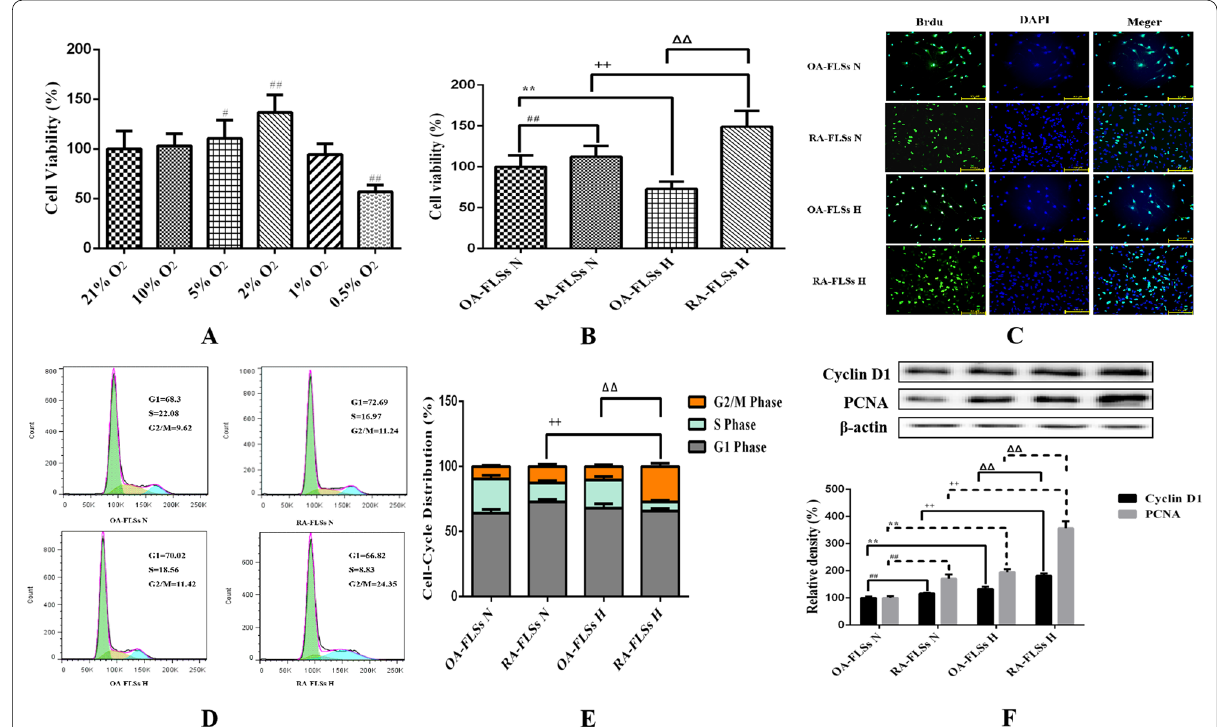
Fig. 1 Effects of hypoxia on the proliferation of OA-FLSs or RA-FLSs. A The effects of different oxygen concentrations on the viability of RA-FLSs were detected by CCK-8 method (mean SD, n 6 from three independent experiments); B The effects of hypoxia on the viability of OA-FLSs ± = or RA-FLSs were detected by CCK-8 method (mean SD, n 6 from three independent experiments); C BrdU was incorporated into OA-FLSs or ± = RA-FLSs, cells were exposed to 21% and 2% O 2 for 24 h, and then BrdU (green) and DAPI (blue) immunostaining were detected; D Flowcytometry analysized the cell proliferation with PI staining after cells were treated with different oxygen concentrations for 24 h; E Histogram depicts quantitative data from the flowcytometry analysis (mean SD, n 5 from three independent experiments); F After exposure to different oxygen ± = concentrations for 24 h, the expression of cyclin D1 and PCNA was analyzed by Western blot (mean SD; n 6 from six independent experiments). ± = # P < 0.05, ## P < 0.01 represents the comparison between OA-FLSs N and RA-FLSs N; *P < 0.05, **P < 0.01 represents the comparison between OA-FLSs N and OA-FLSs H, + P < 0.05, ++ P < 0.01 represents the comparison between RA-FLSs N and RA-FLSs H, Δ P < 0.05, ΔΔ P < 0.01 represents the comparison between OA-FLSs H and RA-FLSs